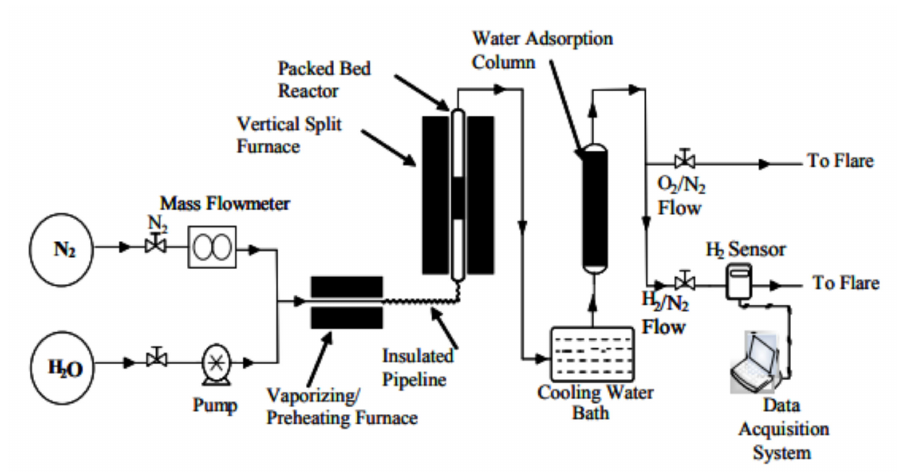
Figure 8. Schematic representation of the experimental setup used for thermochemical water splitting for hydrogen generation. Reprinted from